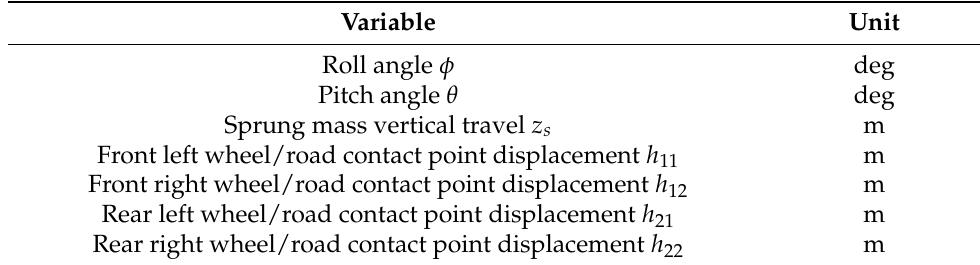
Table 3. Output of the 7-DOF